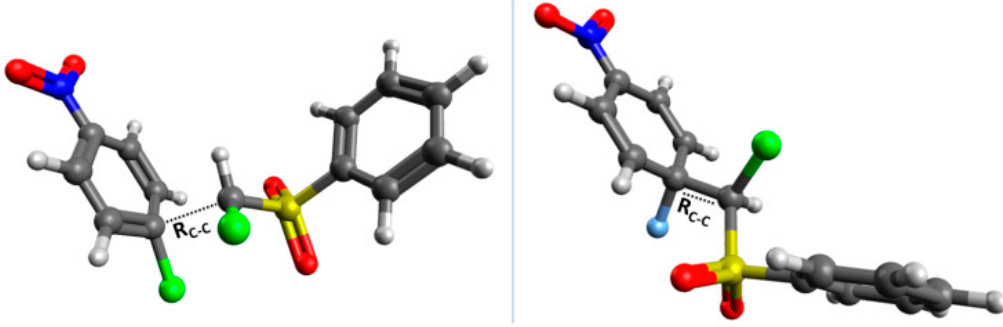
Figure 3. Optimized structures of the σ Cl -adduct as a transition state ( left ) where the distance between reaction centers is R C-C = 2.38 Å and the σ F -adduct as an equilibrium structure ( right ) where R C-C = 1.56 Å.